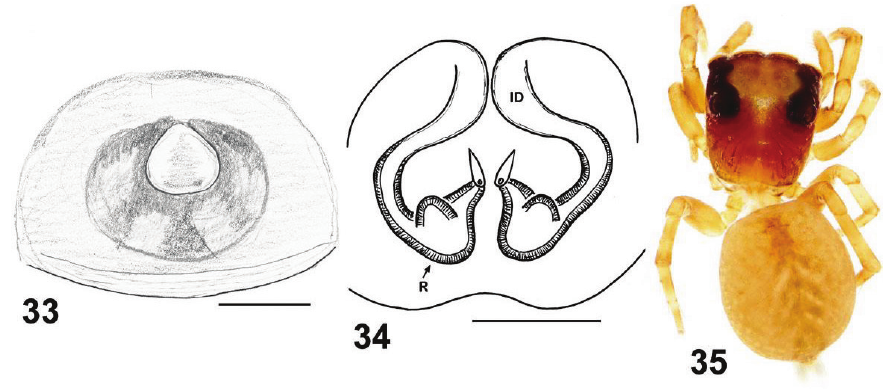
Figures 33–35. Copulatory organs and somatic characters of Eupoa daklak sp. n. 33 epigyne, ventral view 34 vulva, dorsal view 31 female body, dorsal view. Abbreviations as explained in ‘Material and methods’. Scale bars: 0.1